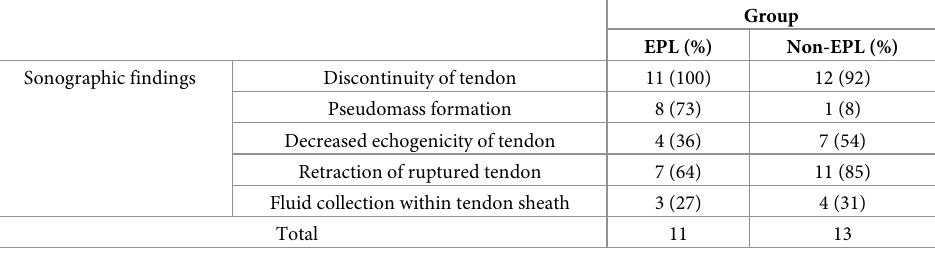
Table 3. Frequency of sonographic findings in extensor pollicis longus tendon ruptures and the other ruptured tendons.